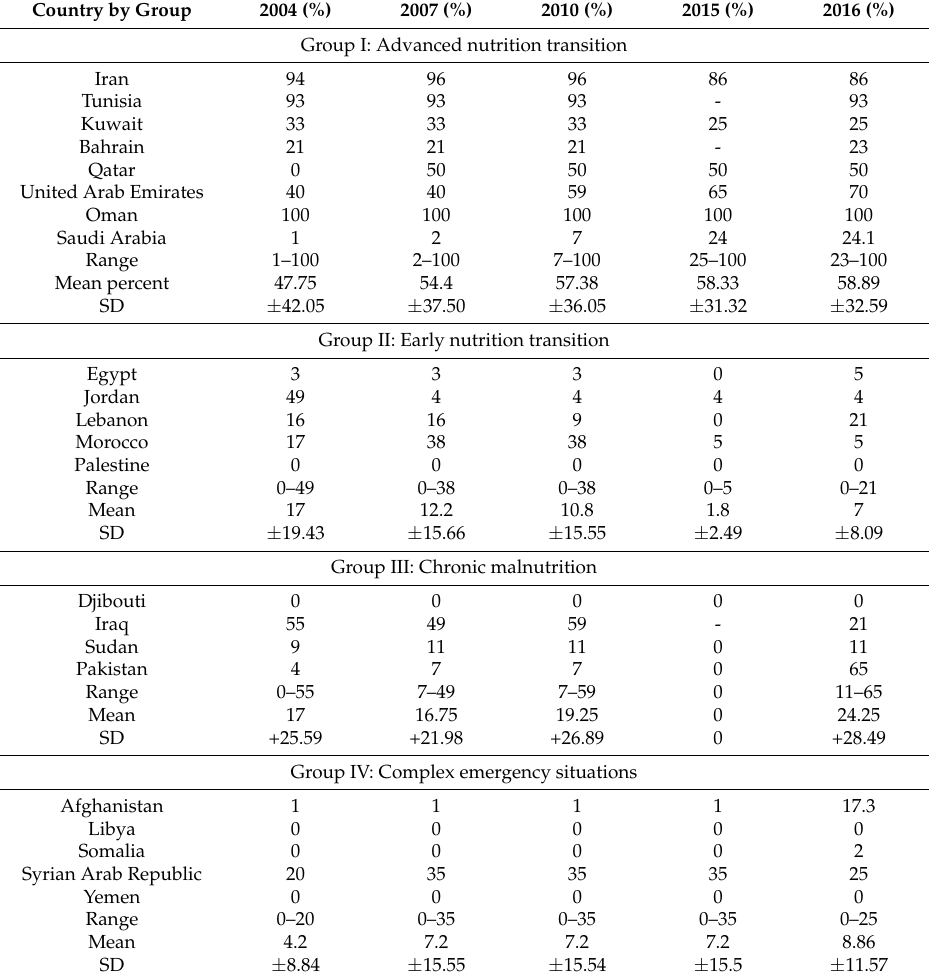
Table 2. Trends in percent designated Baby-Friendly hospitals over the period from 2004 to 2016 in the country groups under study [17].